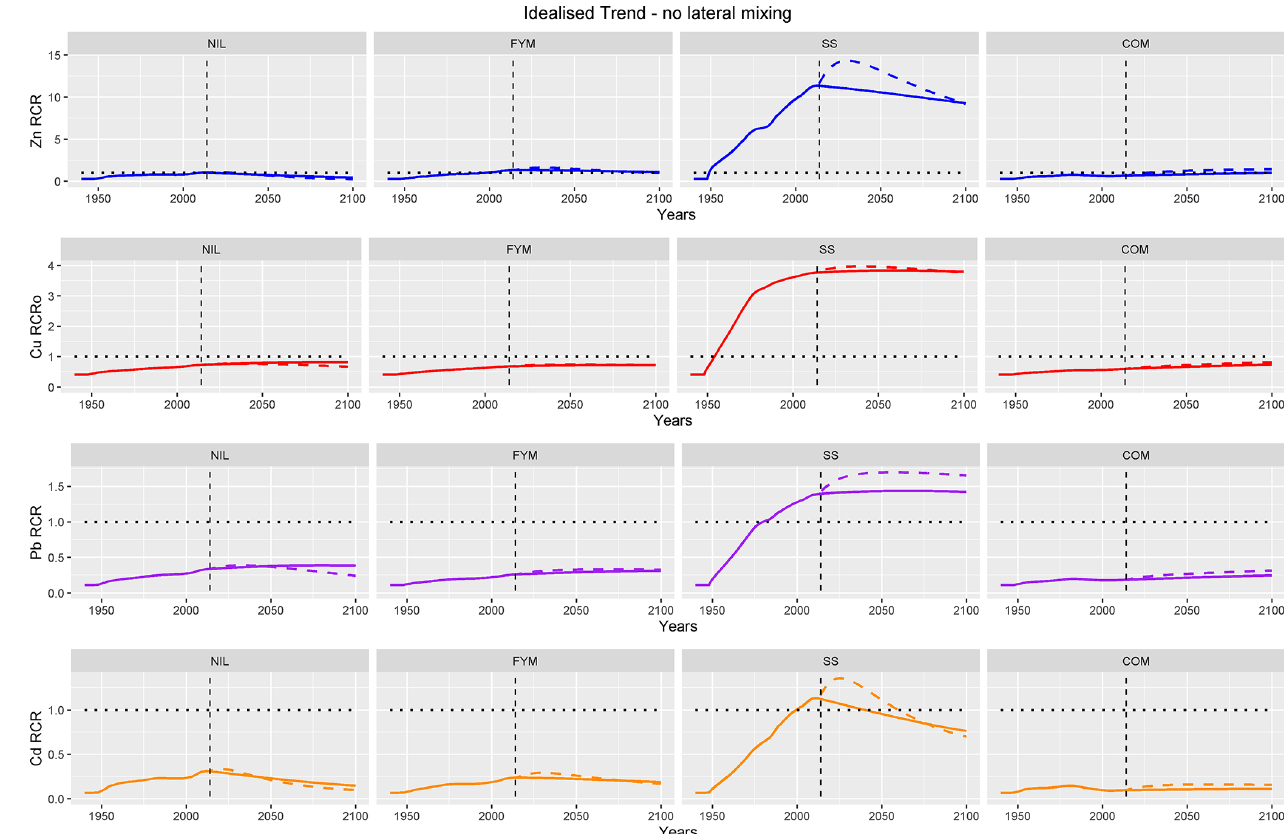
Figure 9. Projected risk characterisation ratios (RCRs) for Zn, Cu, Pb and Cd to 2100 without lateral mixing and with idealised trend inputs. The following two scenarios are considered: constant pH (solid line) and pH decreasing exponentially to 0.5 units below the 2014 value (dotted